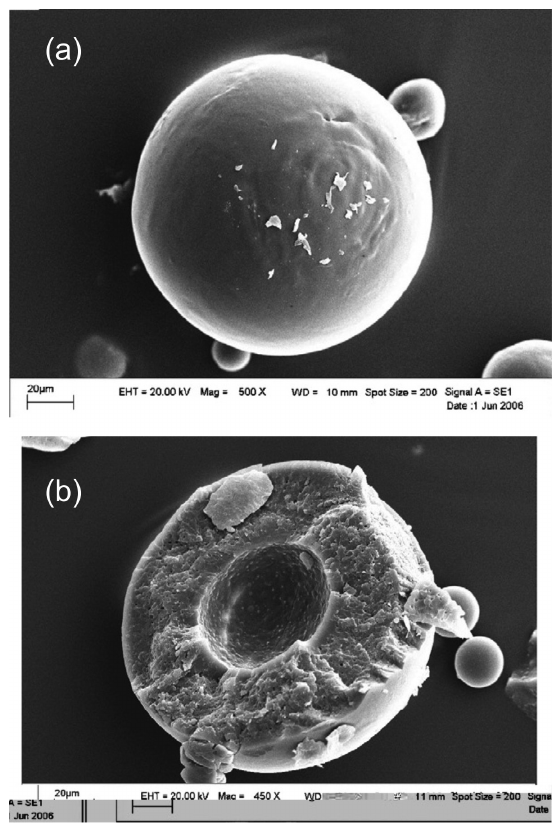
FIGURE 3 - SEM photographs of (a) outer surface of a microsphere, (b) inner surface of a broken half of a microsphere (Pushp, Myung, Hoo, 2007).